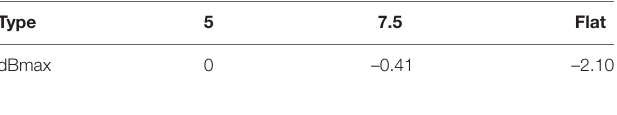
TABLE 3 | The maximum acoustic pressure of three transducers